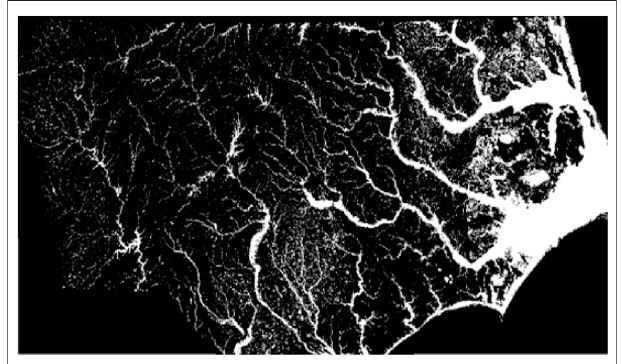
Frontiers in Remote Sensing |